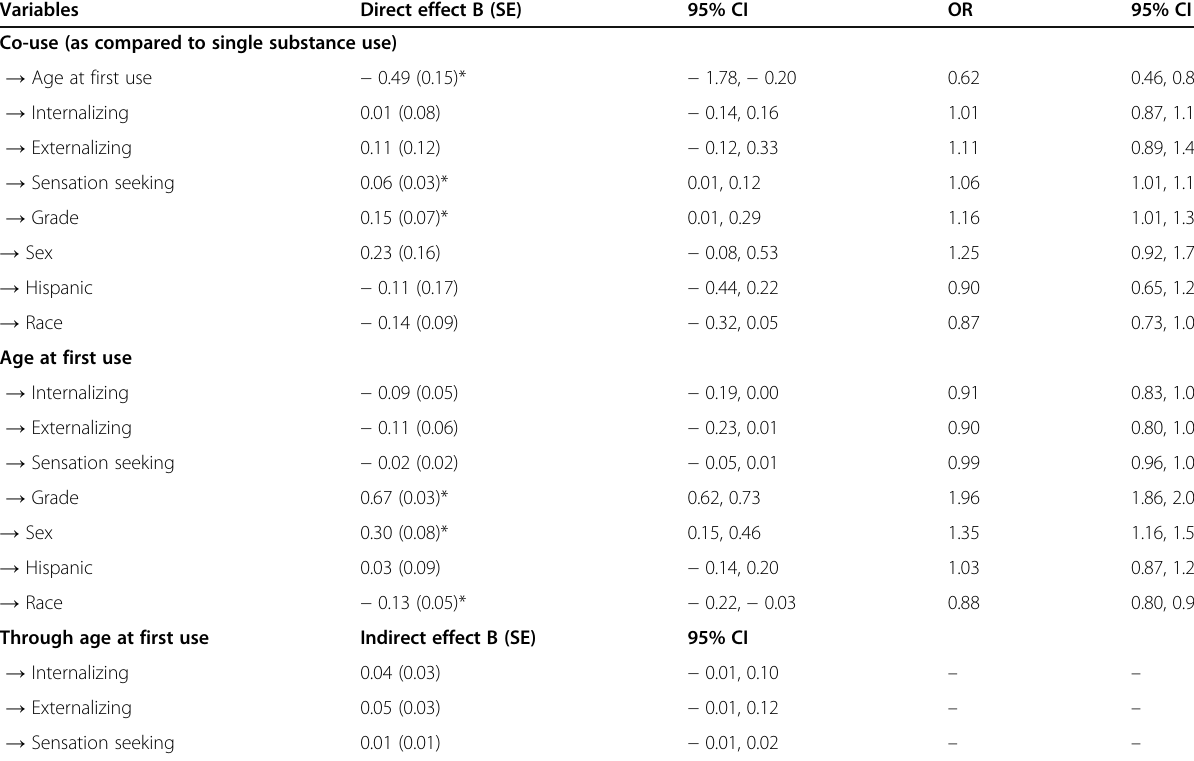
Table 4 Direct and specific indirect effects of youth demographics, psychological constructs of sensation-seeking, internalizing, and externalizing, and age at first use on 30-day tobacco and cannabis use status Variables Direct effect B (SE) 95%